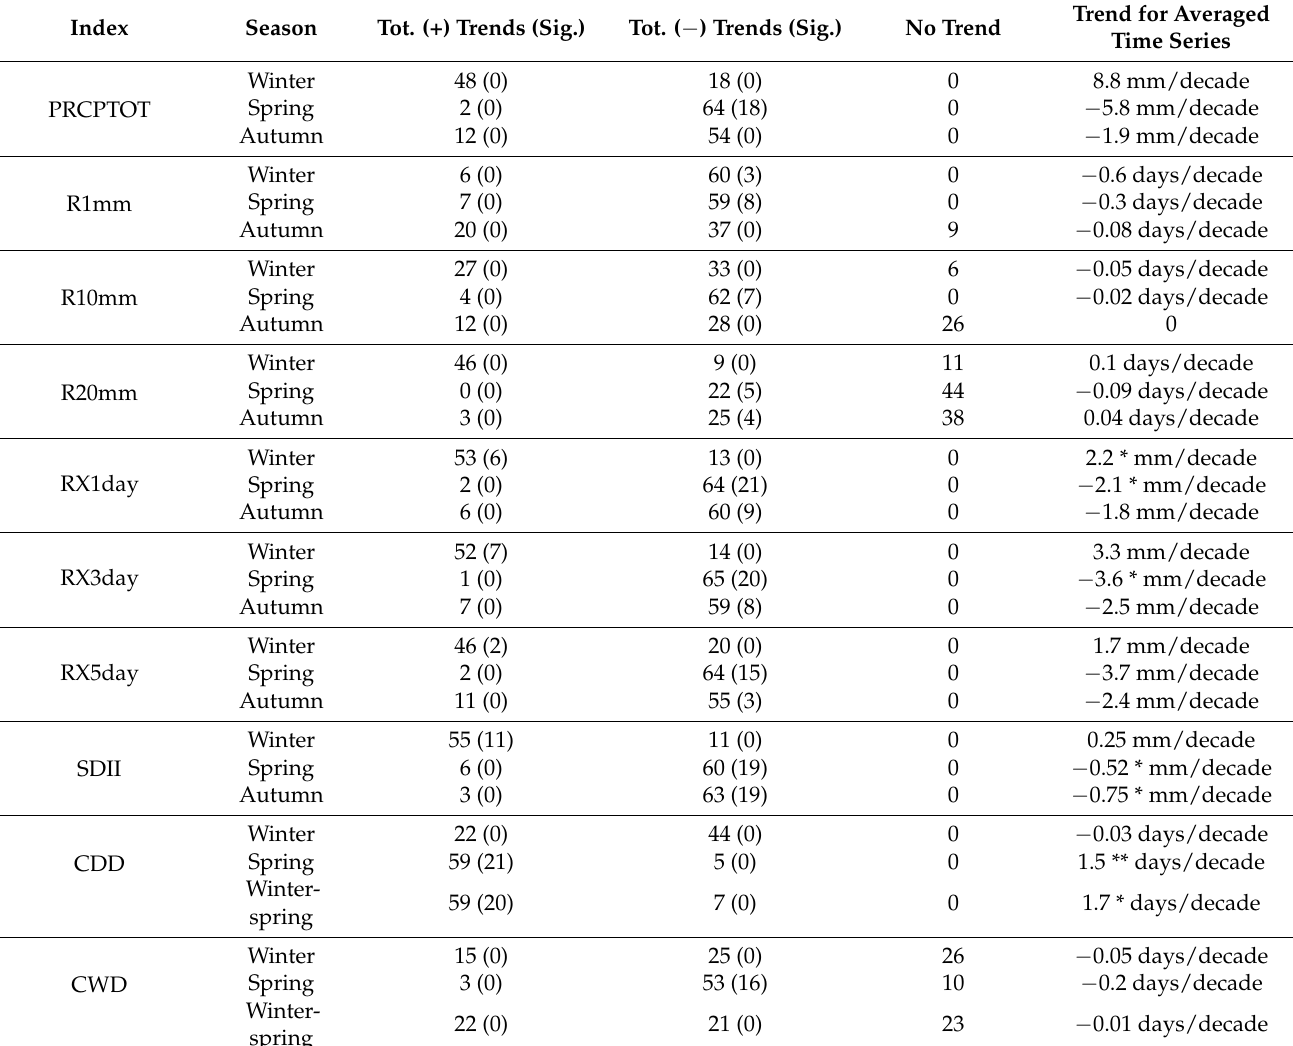
Table 3. Number of stations that showed increasing or decreasing trends along with the trend values for the averaged time series, 1970–2020. The number in brackets represents the counts of stations with statistically significant trends at the 95% confidence level. Asterisks indicate significance level: * = ( p < 0.1), ** = ( p <